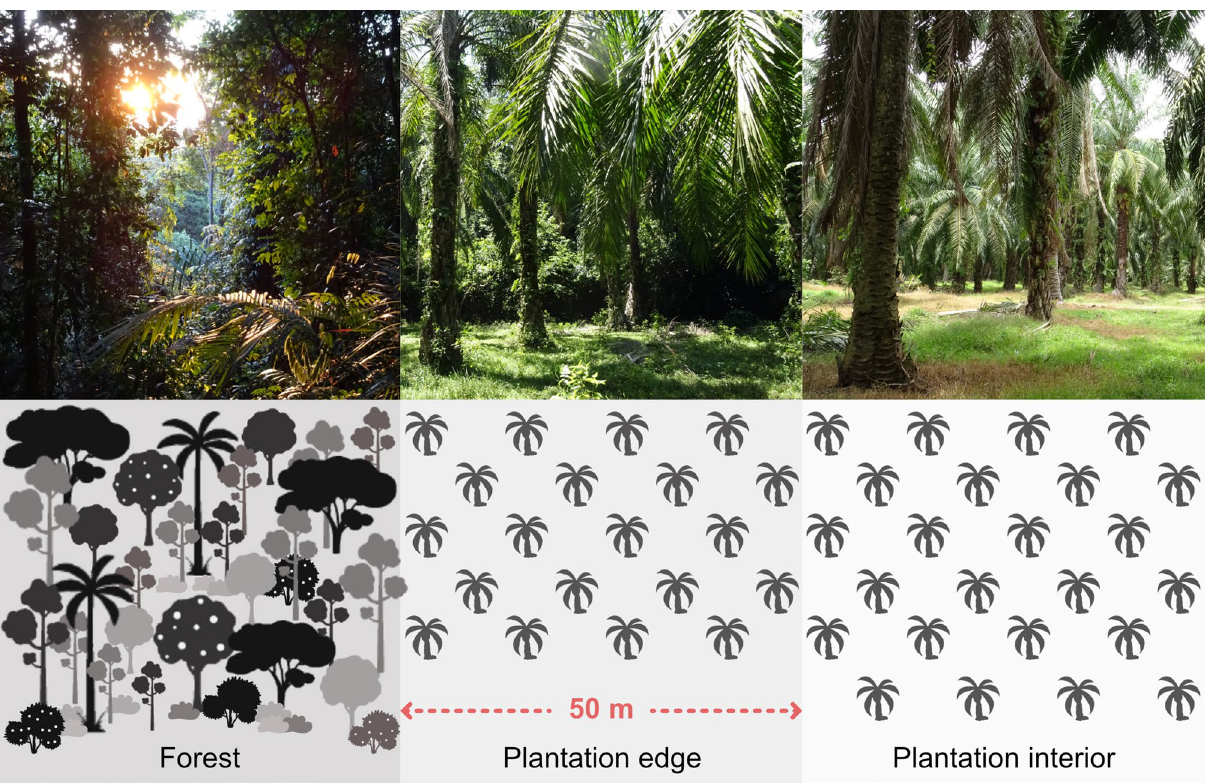
Figure 1. Habitat types at the study site in Segari, Peninsular Malaysia. We distinguished between primary rainforest, the plantation edge, i.e. plantation area within 50 m from the forest border, and the plantation interior, i.e. areas of plantation at a distance of more than 50 m from the forest border. Photos by A.